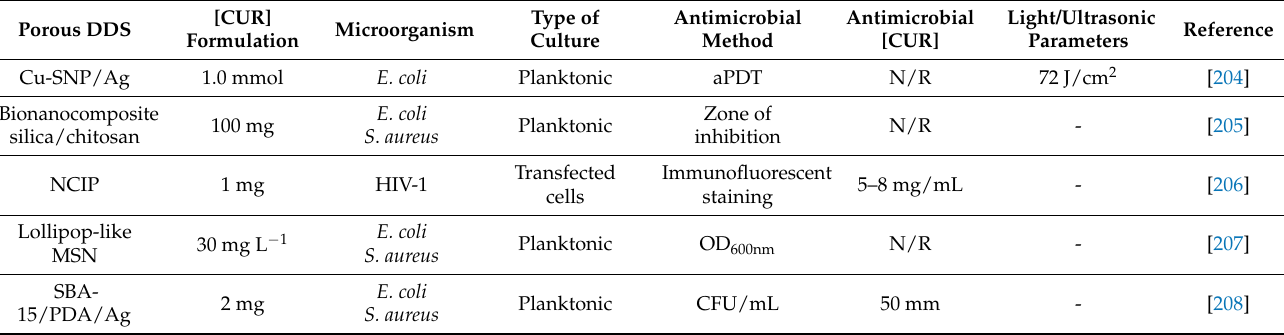
Figure 7. Schematic representation of a porous particle. Table 9. Antimicrobial studies performed with CUR in porous